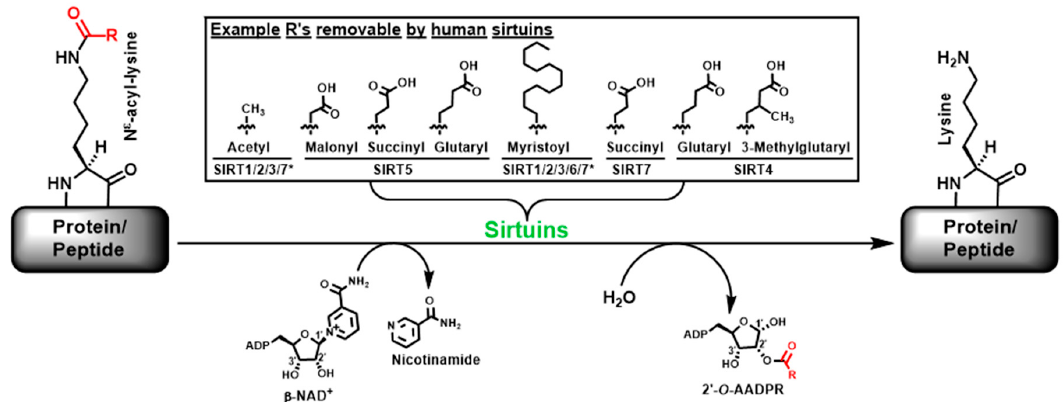
Figure 1. The sirtuin-catalyzed β -NAD + -dependent deacylation of protein-based or peptide-based N ε -acyl-lysine substrates. Example R groups of R-C(=O)- removable by different human sirtuins are shown in the box. The two asterisks in the box denote that the SIRT7-catalyzed deacetylation and demyristoylation become appreciable only in the presence of dsDNA, rRNA, or tRNA.